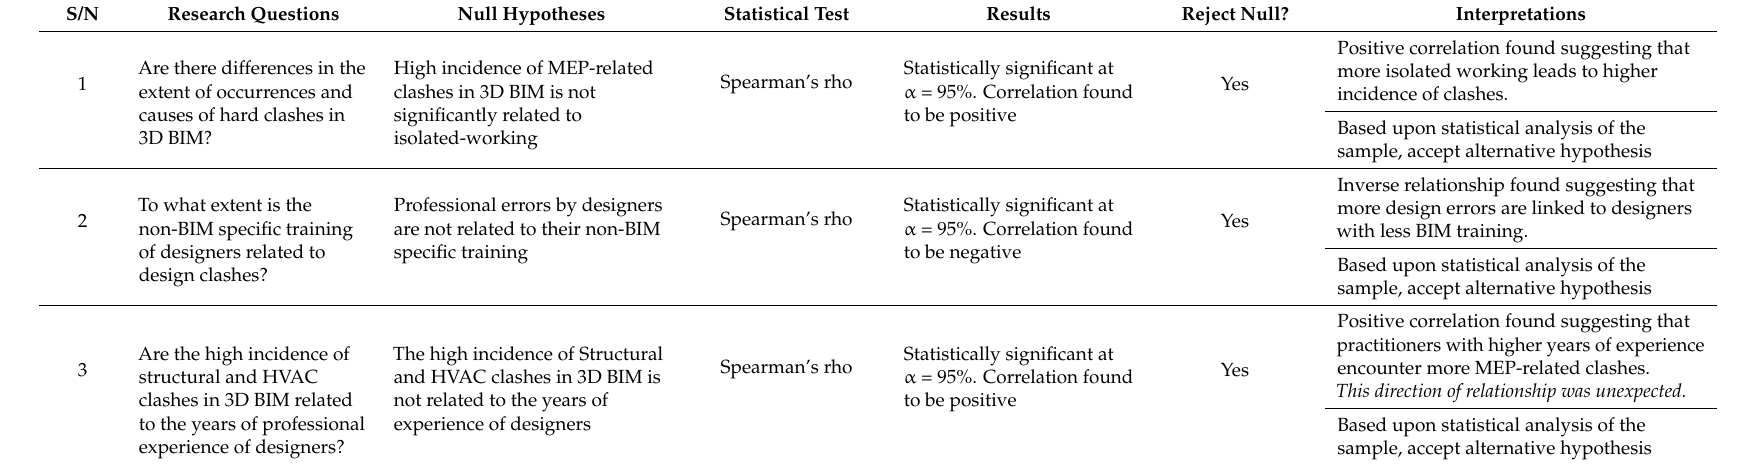
Table 6. Summary and interpretations of the results of the tested